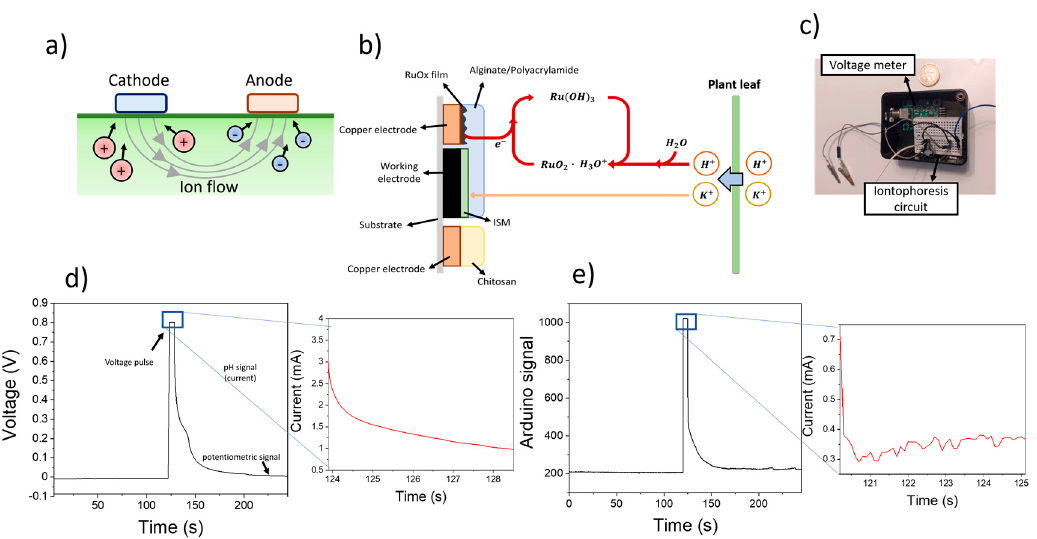
Figure 2. ( a ) Schematical representation of the reversed iontophoresis process, whereby the application of a voltage between the cathode and anode electrodes led to the extraction of cations and anions from the plant leaf respectively. ( b ) The sensing process is represented, involving the extraction of both K + and H + ions from the plant, which trigger an electrochemical reaction by the RuO x film. ( c ) Picture of the microcontroller-based circuit used for the measurement of pH and K + ions. ( d ) Plot showing the potentiometric changes of screen-printed electrodes before and after the use of 0.8 V for ion extraction. ( e ) Sensing plot obtained after using the Arduino-based device for the measurement.